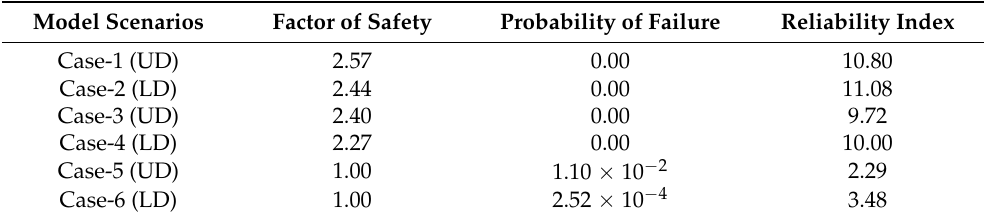
Table 3. The deterministic factor of safety (FoS) and the probability of failure (P f ) of the Drake caprock shale in different studied cases. Corresponding reliability index ( β ) values are also